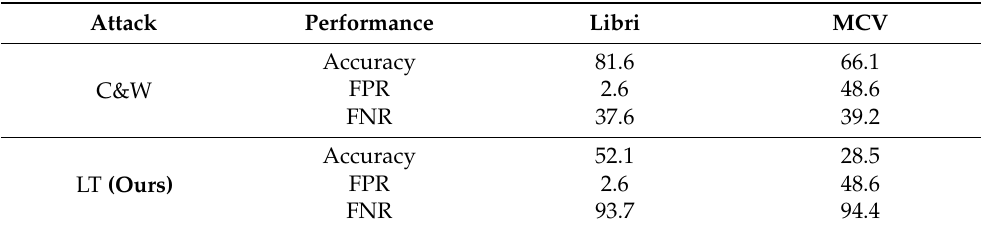
Table 1. Comparison of detection accuracy (%) on the LOGITS NOISE